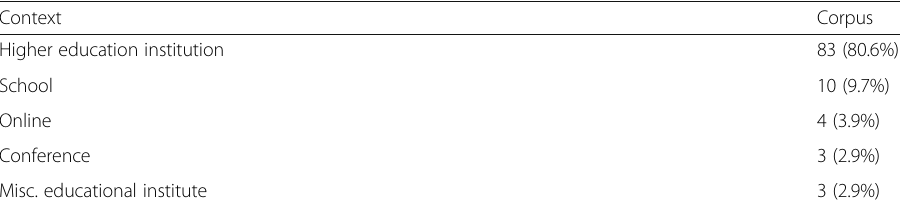
Table 3 Frequency (Percentage) of study context